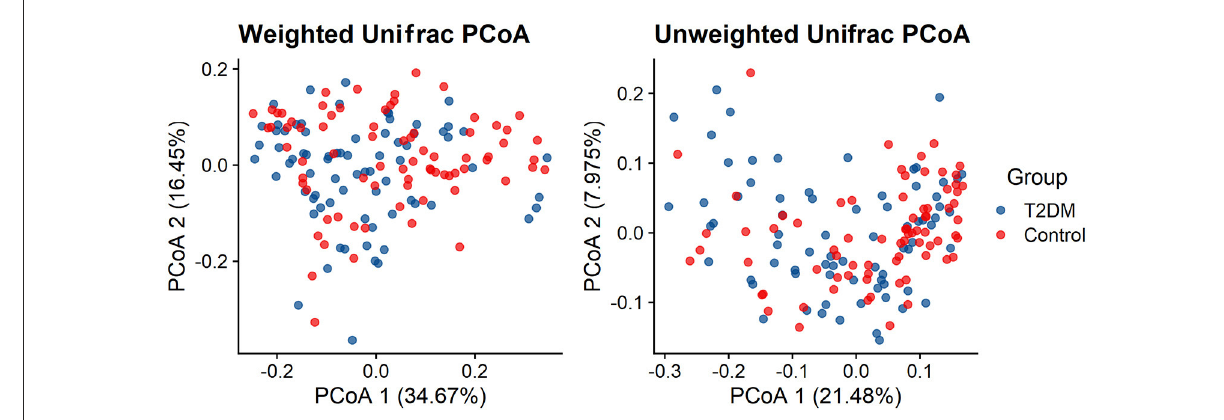
FIGURE2 Principal coordinate analysis illustrating the grouping patterns of the T2DM and control individuals based on the unweighted UniFrac and weighted UniFrac distances (both p < 0.001).